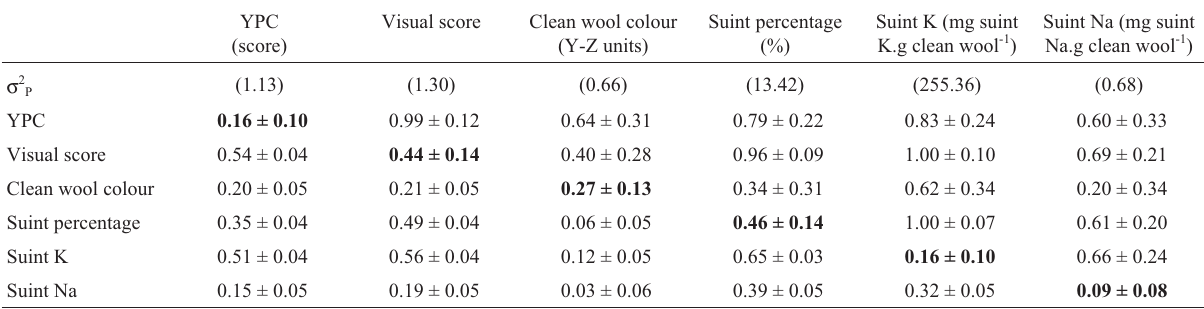
Table 2 - Estimates for genetic (above diagonal) and phenotypic (below diagonal) correlations ( ± standard error) between YPC, Visual score, clean wool colour, suint percentage and minerals analysed in Corriedale flock. Hereability estimates are shown in